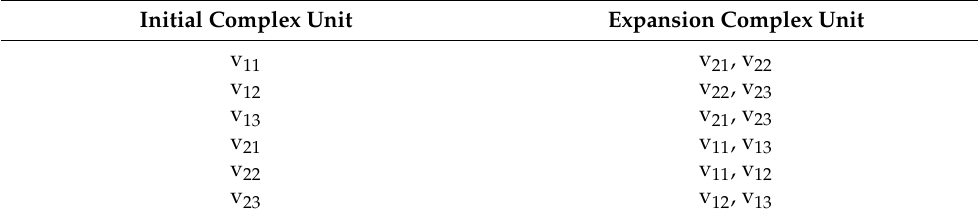
Table 1. The relationship between the expansion complex unit and the initial complex unit. Initial Complex Unit Expansion Complex Unit v 11 v 21 , v 22 v